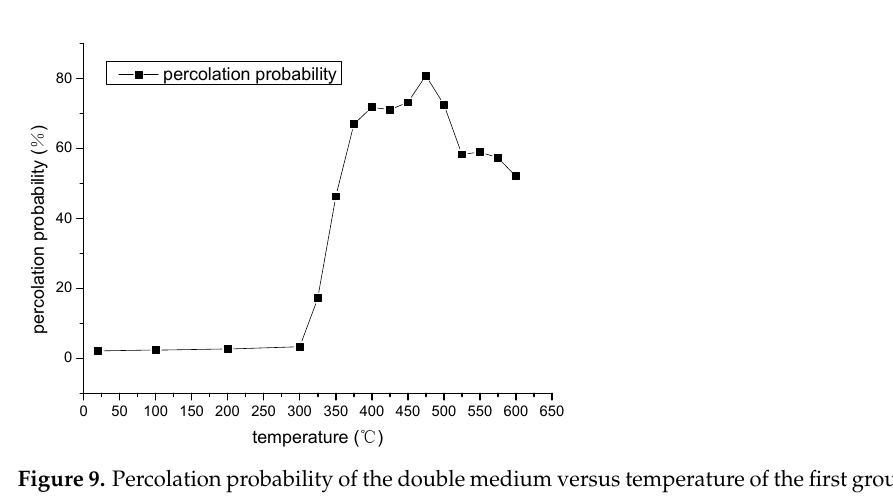
Figure 9. Percolation probability of the double medium versus temperature of the first group sam ‐ ples.